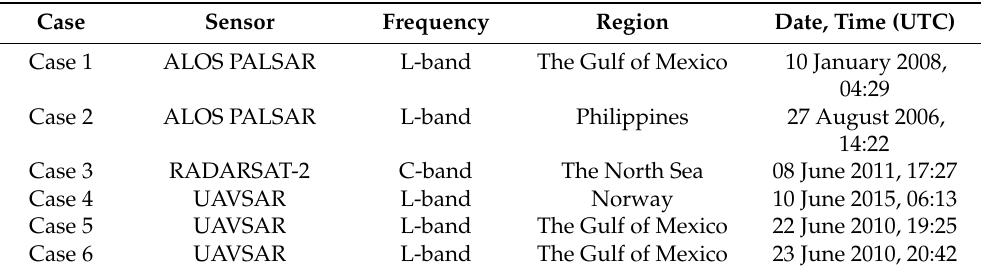
Table 1. Details of the six